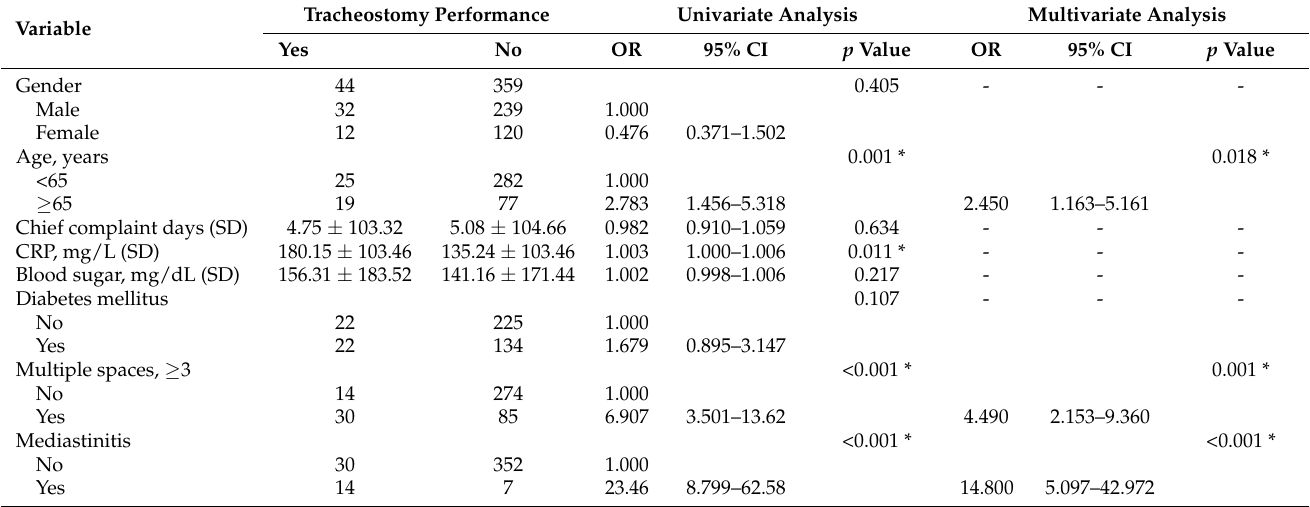
Table 2. Univariate and multivariate analysis of tracheostomy performance in 403 patients with deep neck infection. Tracheostomy Variable